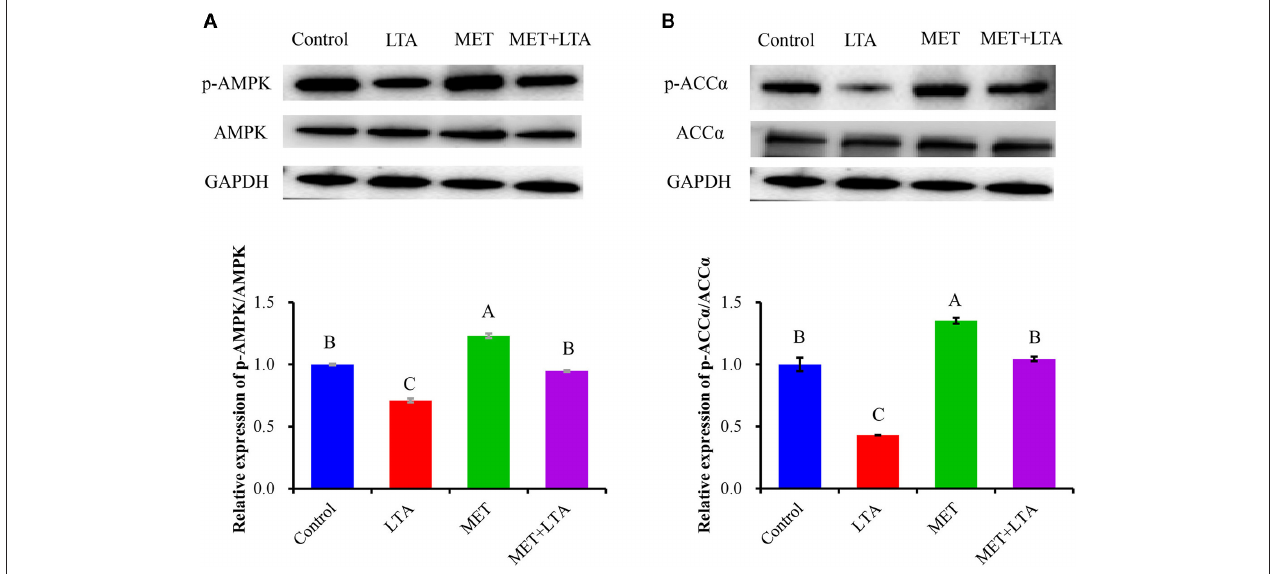
FIGURE 3 | Expression of proteins related to the AMPK signaling pathway. The expression of AMPK signaling–related proteins was measured by Western blot analysis in PBMECs treated with metformin 3mM for 12h, and LTA (100 µ g/mL) for 6h. Graphs show densitometric analysis (expressed as P-AMPK ratio to AMPK and P-ACC to ACC) from each band from three independent experiments. Values represent means ± SEM. LTA, lipoteichoic acid; MET, metformin. Different uppercase letters (A–C) on the top of bars indicate significant differences ( n = 3, p < 0.05) vs. among the groups. This study measured the phosphorylation of both (A) AMPK and (B) ACC expression level.